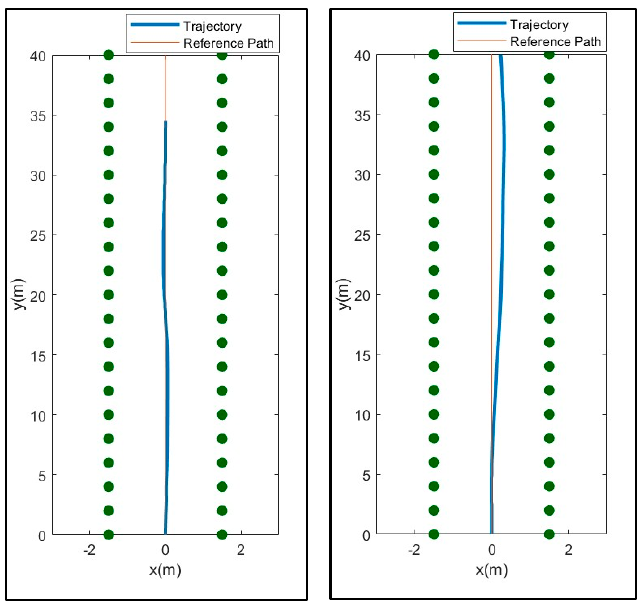
Figure 15. Robot trajectories during the test. Green circles represent the tree trunks.